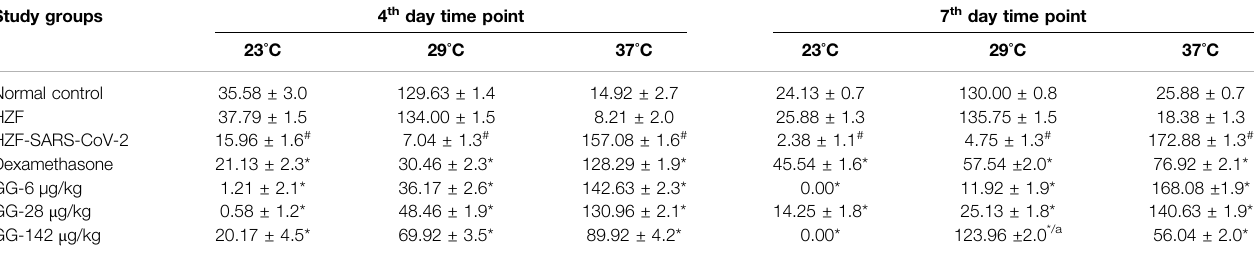
TABLE 2 | Changes to body temperature as assessed by behavioral fever. Time spent (in seconds) by individual fi sh in three different temperature chambers (23, 29, and 37 ° C). Dataisshown asmean ± S.D.of24individuals,analyzedbyTwo-WayANOVAfollowedbyTukey ’ smultiplecomparisontest(#)denotes p < 0.0001compared to the normal control (*) denotes p < 0.0001 compared to disease control, and (a) denotes p < 0.0001 when compared to 37 ° C.